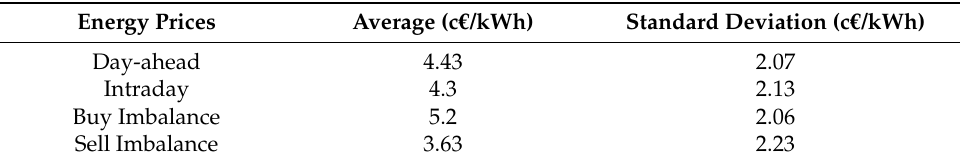
Table 2. Real data of energy prices for the whole year analyzed.